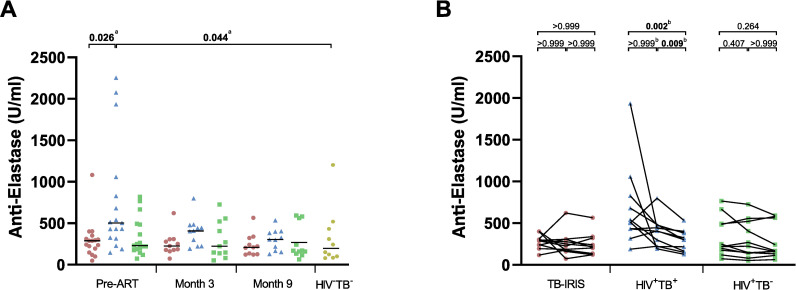
Plasma levels of anti-elastase in TB-IRIS patients and controls.Graphs show a comparison between groups (A), as well as changes over time for individual patients (B) in the median plasma levels of anti-elastase (U/ml) measured prior to ART, and at 3 months and 9 months of ART. Significant overall differences between TB-IRIS patients (red circles), HIV+TB+ (blue triangles), HIV+TB- (green squares), and HIV-TB- (yellow hexagons) controls were calculated using Kruskal-Wallis tests, with Dunn’s post-hoc test shown as capped lines to highlight specific differences between individual groups (A). Significant variation over time was calculated for each group using Friedman tests, with Dunn’s post-hoc test shown as capped lines to highlight specific differences between individual time points (B). Out of 17 TB-IRIS patients with samples available pre-ART, only 11 had samples available at both month 3 and month 9. The total number of patients analysed over time was thus 11 for each group. Analysis were performed between all groups at each time point, and between every time points for each group with the level of significance was set to P < 0.05. Non-significant p-values have been omitted from the graphs. Overall Kruskal-Wallis p-value was ap = 0.009 and overall Friedman p-value was bp ≤ 0.001.